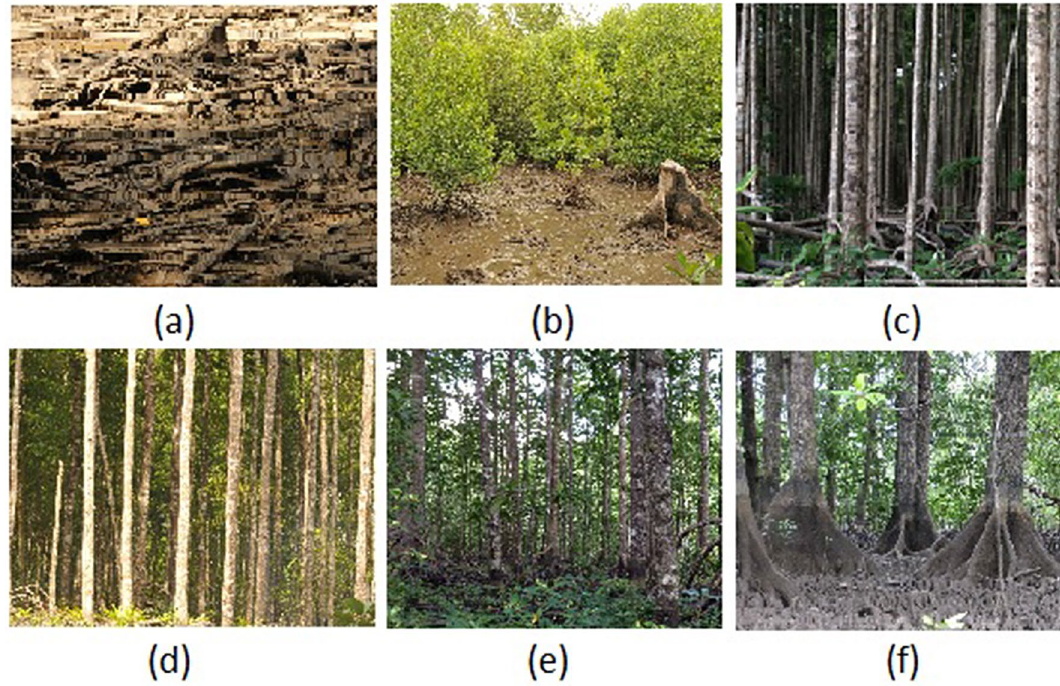
Figure 1. General conditions of mangrove stand at: ( a ) 0 years, ( b ) 5 years, ( c ) 10 years, ( d ) 15 years, and ( e ) 25 years post-harvest; and ( f ) in protected or unharvested